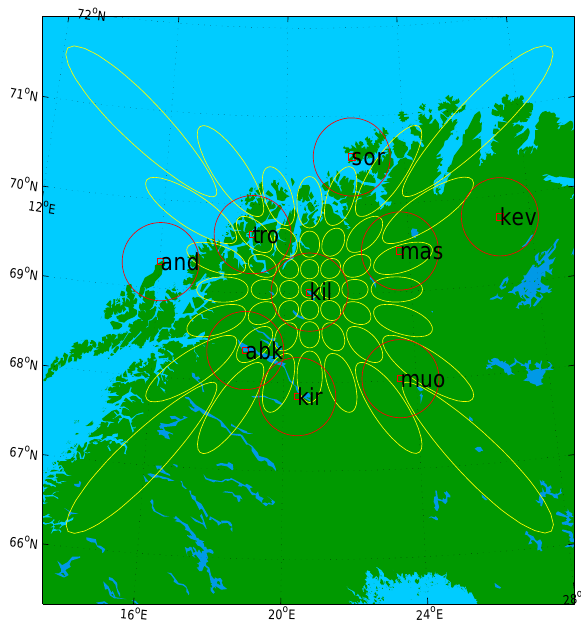
Fig. 1. Beam projection of IRIS at 90km altitude (yellow) and es- timated fields of view of selected magnetometers from the IMAGE chain (red circles). Coordinates are in geographic latitude and lon-